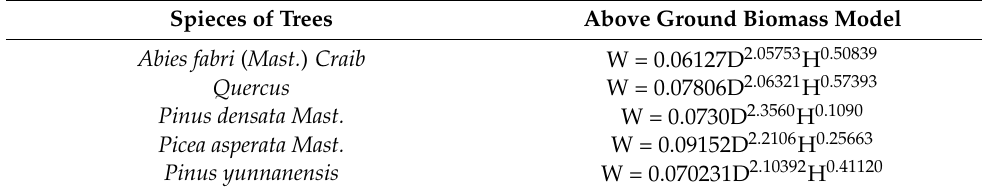
Table 4. Above ground biomass model of main tree species in Shangri-La